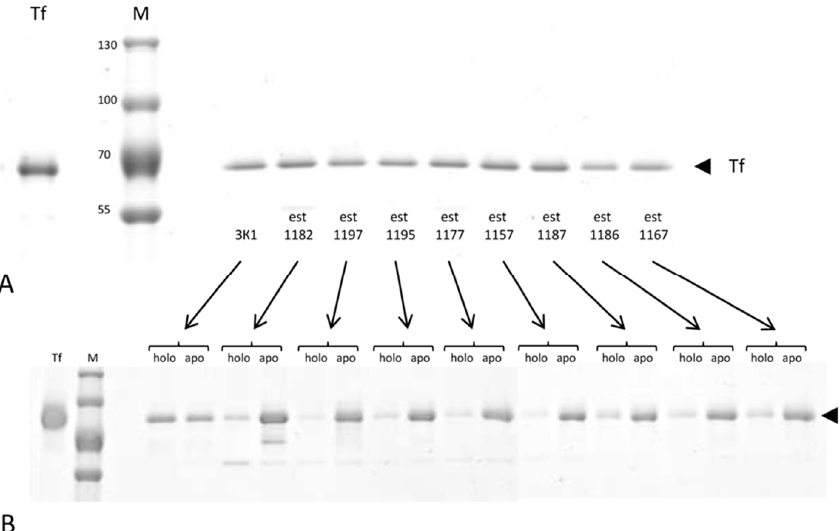
Figure 3. Demonstration of a marked decrease in the proportion of iron-saturated transferrin (holo- Tf) relative to iron-free transferrin (apo-Tf) in the blood of CrO patients using a method based on immunoaffinity chromatography followed by the electrophoretic fractionation of specifically bound and then eluted transferrin isoforms. M is a protein marker; marker protein sizes in kDa are indicated. Tf is a commercial preparation of transferrin. Gradient: 5–19% SDS-polyacrylamide gel. ( A ) immunosorbents—both antibodies simultaneously; ( B ) two separate immunosorbents: aTf1 (anti-holo-Tf, holo) and aTf2 (anti-apo-Tf, apo). Markers: est—CrO patients,